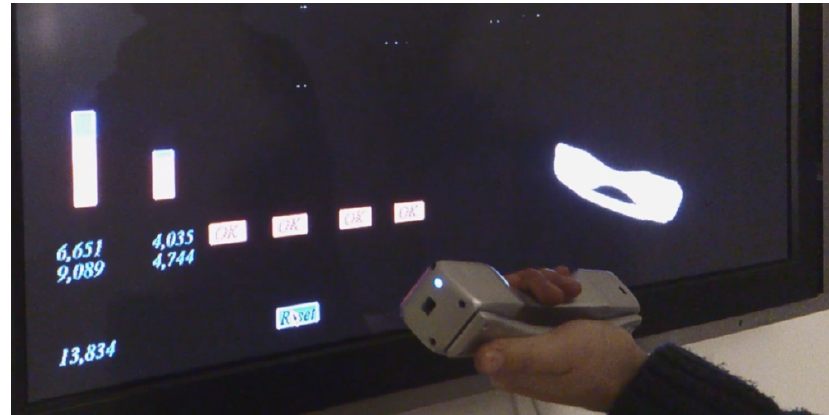
Figure 7. Force and motion of wireless hand device.